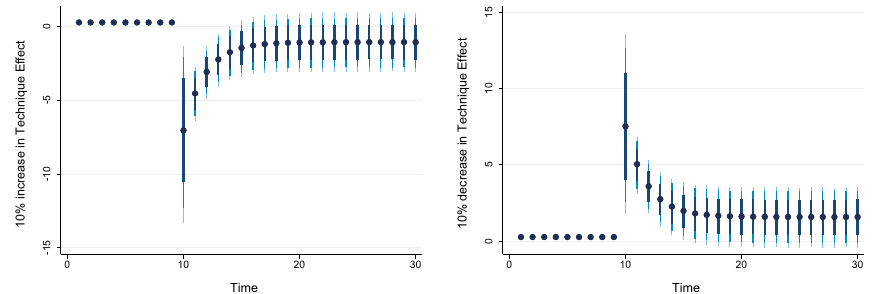
Fig. 2 The Impulse Response Plot for Technique Effect and CO 2 Emissions. Figure 2 presents an increase and a decrease by 10% in technique effect and its effect on CO 2 emissions where dots denote average prediction value. The dark blue to light blue line shows 75, 90, and 95% confidence interval, respectively